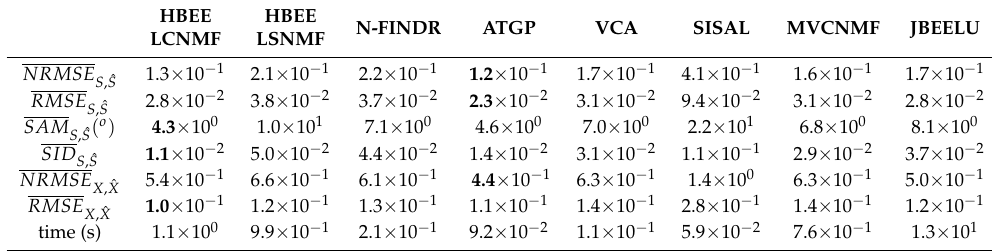
Table 10. Compared mean performances for each method applied to the Mauzac data set. The mean performance of HBEE-LSNMF has been calculated with the 4 endmembers estimated by this method. HBEE HBEE N-FINDR ATGP LCNMF LSNMF